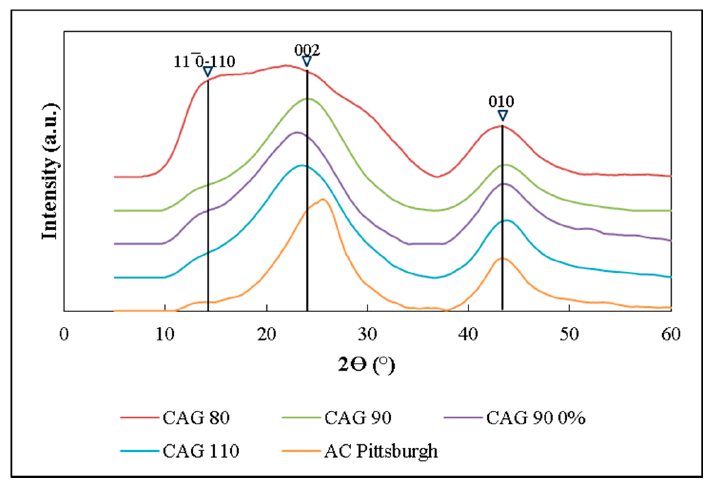
Figure 5. Normalized XRD pattern for CAG 80, 90, 90 0%, 110, and commercial activated carbon Pittsburgh. Table 6. Graphite crystallite dimensions (from X ‐ ray diffraction (XRD) analysis) and bands D and G areas ratio (from Raman spectroscopy analysis).